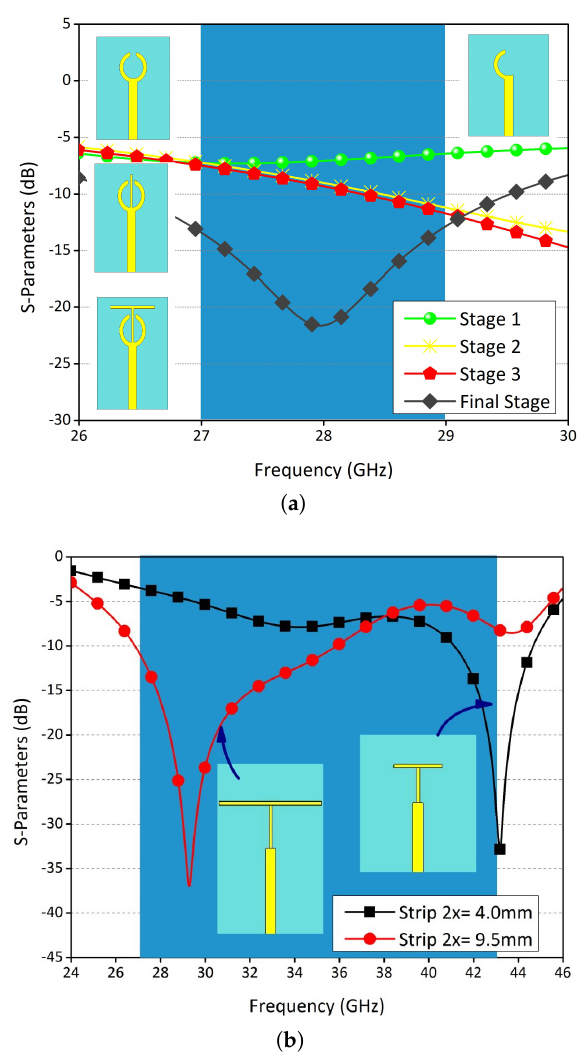
Figure 2. Design Evolution ( a ) Four-stage design evolution ( b ) Design Evoultion w.r.t T